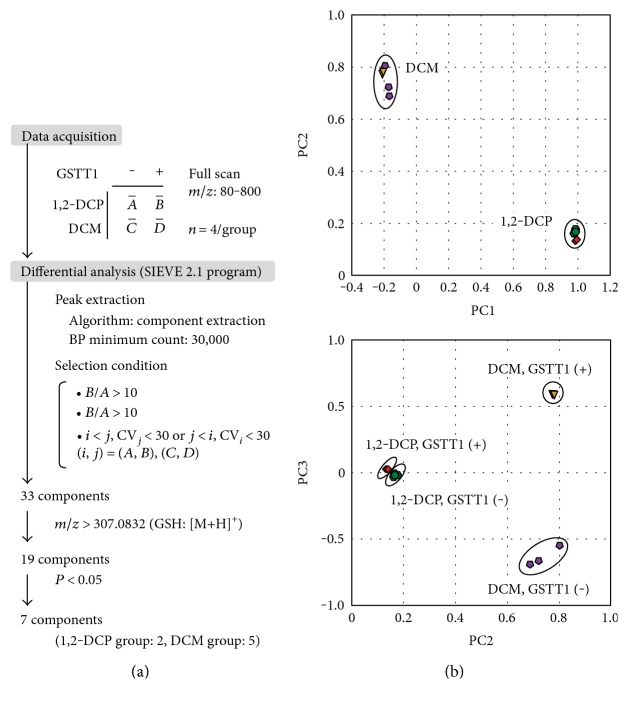
Effect of GSTT1 on the reactivity of halogenated hydrocarbon with GSH. (a) Data-processing scheme for differential analysis of four cases: in vitro reaction of 1,2-DCP or DCM with GSH in the presence or absence of GSTT1. The seven component products are summarized in Table 1. (b) Principal component analysis (PCA) based on differentially detected peaks across incubation component conditions. Green, 1,2-DCP without GSTT1; red, 1,2-DCP with GSTT1; purple, DCM without GSTT1; and yellow, DCM with GSTT1. This PCA of acquired data, such as peak information including integrated intensity, was performed by using the SIEVE 2.1 program. Upper panel, the first second-principal components; lower panel, the third two-principal components of all extracted data are plotted. n = 4 in each group.